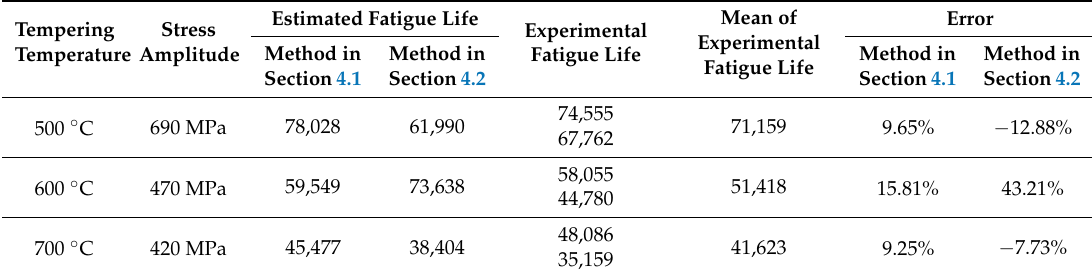
Table 11. Method validation and